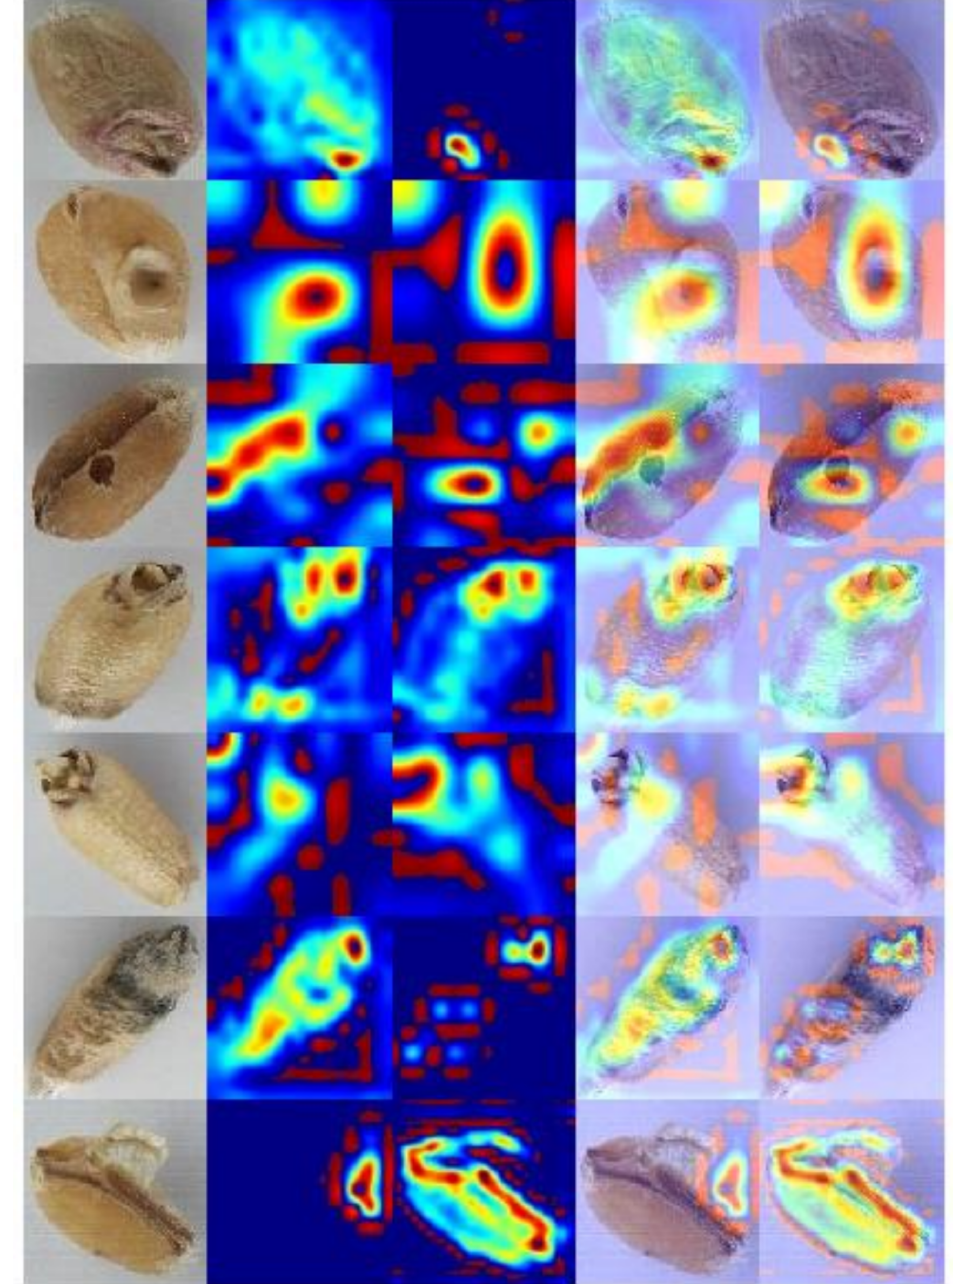
Figure 5. Sample visualization: Grad-CAM. ( Left ) original image, ( Center-left ) activated heatmaps without attention mechanism, ( Center ) activated heatmaps with attention mechanism, ( Center- Right ) heatmap superimposed on original image without attention mechanism, and ( Right ) heatmap superimposed on original image with attention